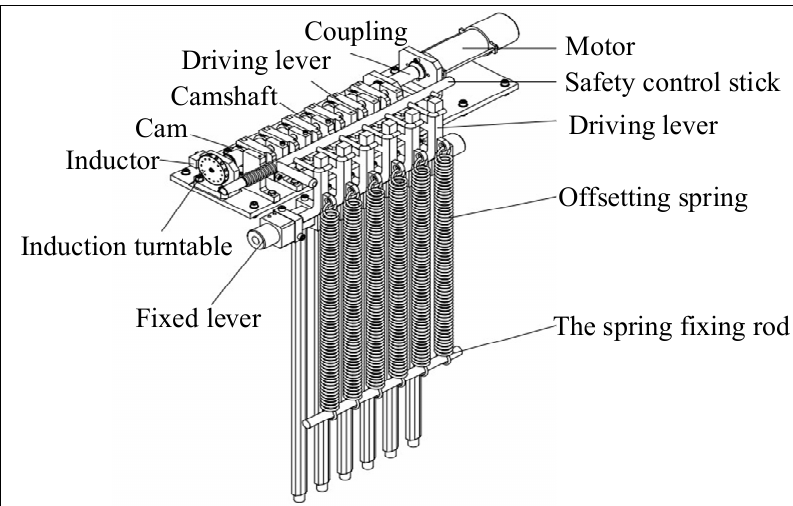
Figure 3. Net opening and closing mechanism.